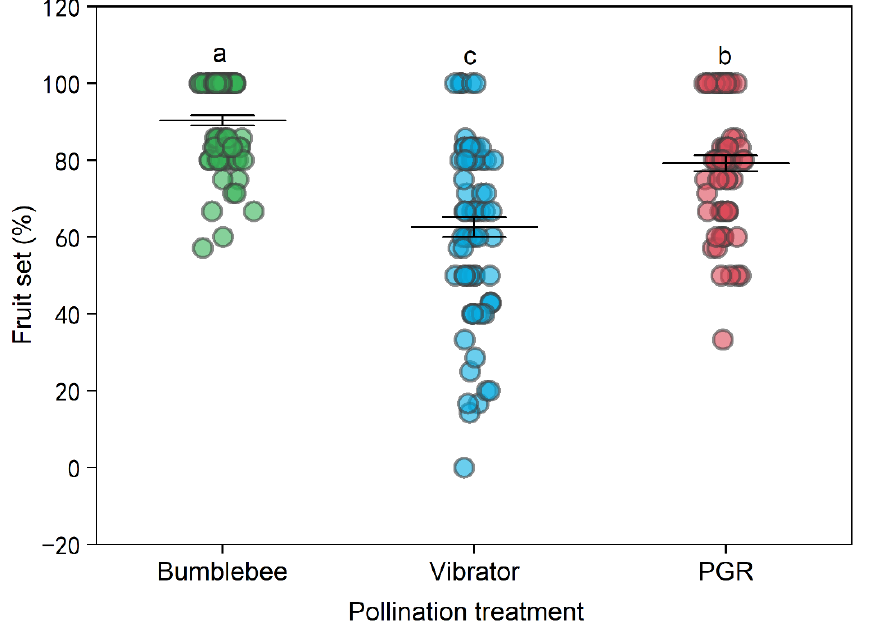
Figure 2. Fruit set of tomato by different pollination treatments. A total of 221 tomato plants from three greenhouses were observed for fruit set. Data are presented as the mean ± 95% confidence interval. A general linear model was used to compare the fruit set among different pollination treatments. Different letters indicate significant differences in fruit set based on the Duncan test α = 0.05.